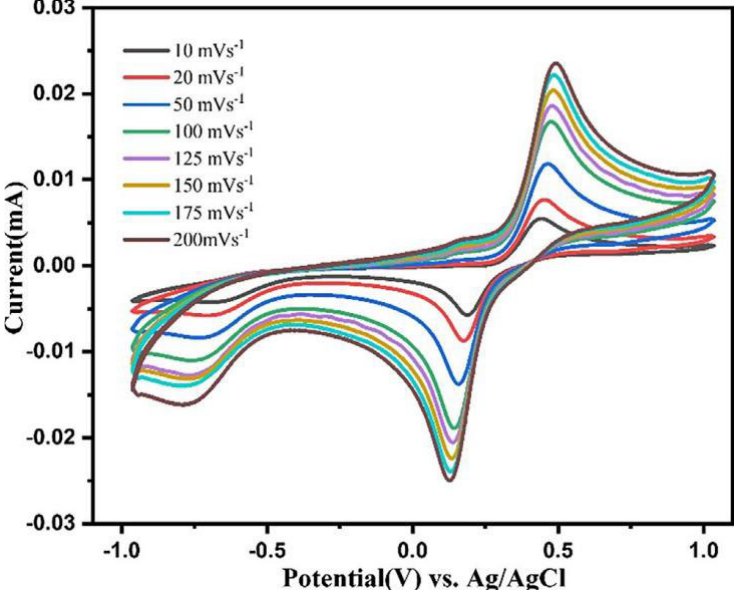
Figure 43. Cyclic voltammetry response of Lac/Au/MXene/GCE at pH 5 with 0.3 mM catechol concentration at scan rates of 10, 20, 50, 100, 125, 150, 175, and 200 mVs −1 [82]. According to the Randles Sevcik equation, ip is explicitly related to the massive concentration of catechol at a constant scan rate. The region of the redox loop rose with the rise in catechol concentration, indicating that the current enhanced with the rise in catechol concentration. As scan speeds rose, anodic peaks moved to high positive potentials, as cathodic peaks moved to high negative potentials. If the plot of peak current ranges straightly with the sweep rate (m), the limiting step is the transfer of electrons from analyte to electrode, according to the literature. There was a direct rise in peak current and a positive shift in peak potential as the scan rate was raised. On graphing the peak current (Ip) against the scan rate (v) 1/2 , a straight line was obtained, conforming the equation Ipa (mA) = 0.00165 v 1/2 (mVs1) − 1/2 + 2.56831 (R 2 = 0.9998) in Figure 44. Their diffusion-controlled mechanism is indicated by this linear correlation. For the catechol concentrations of 0.3, 0.05, and 0.01 mM, Figure 45 compares the observation of catechol utilizing bare GCE, Au/MXene/GCE, and Lac/Au/MXene/GCE at a scan rate of 100 mV s1. The peak current related to catechol oxidation was higher for Lac/Au/MXene/GCE compared with Au/MXene/GCE and bare CE, according to the CV response. Even at 0.05 mM catechol, the enzyme laccase immobilized on Au/MXene increases on the account of catechol oxidation, resulting in a noticeable increase in peak current. From the foregoing, it may be deduced that it is a good candidate for sensing catechol traces